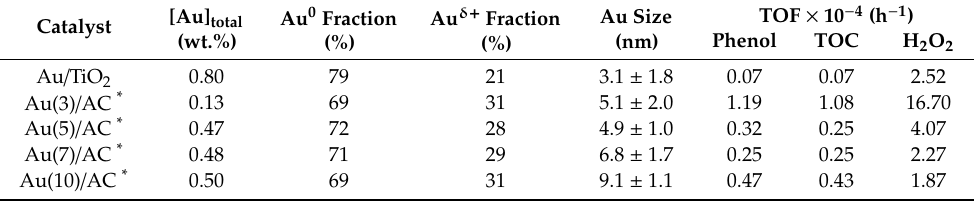
Table 3. Gold loading, particle size and percentage of exposed surface gold species of the catalysts, and turnover frequency (TOF) values of phenol, TOC oxidation, and hydrogen peroxide decomposition (experimental conditions: [Phenol] = 5 g / L, [Catalyst] = 2.7 g / L, V H2O2 = 5 mL, t = 24 h and V solution = 45 mL). Adapted from Quintanilla et al.